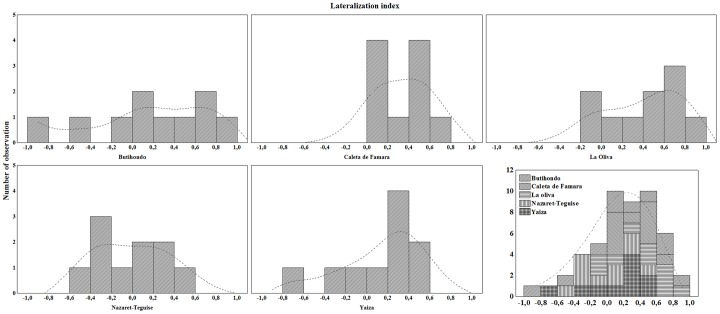
Frequency plots showing the number of observations of each value plotted on the X axis.The X axis is the Lateralization Index (LI) for each individual, where LI = (right−left)/(right+neutral+left). Fisher exact test p two-tailed was used in order to test the null hypothesis: no refuge preference (see also Table 2).